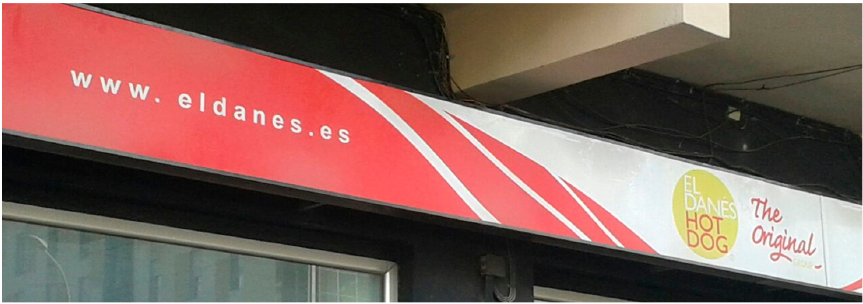
Figure 43. Valencia: Language contact on a food shop sign .